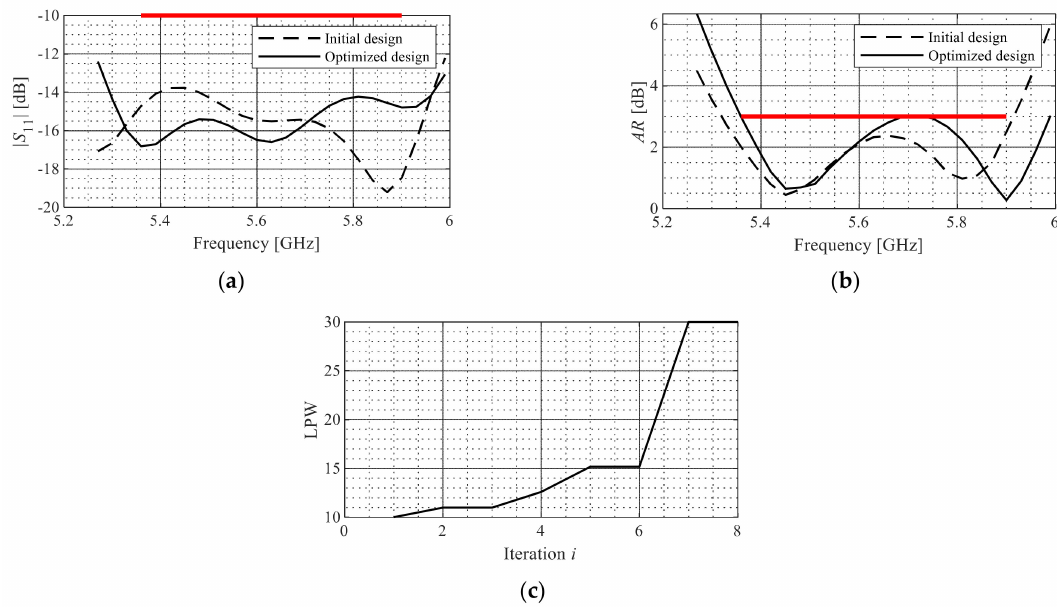
Figure 26. Results for Antenna of Figure 25 using the algorithm [46] incorporating multi-fidelity model management and adaptive penalty coefficients: ( a ) reflection responses, ( b ) axial ratio re- sponses, ( c ) evolution of the model fidelity. The horizontal lines represent the design